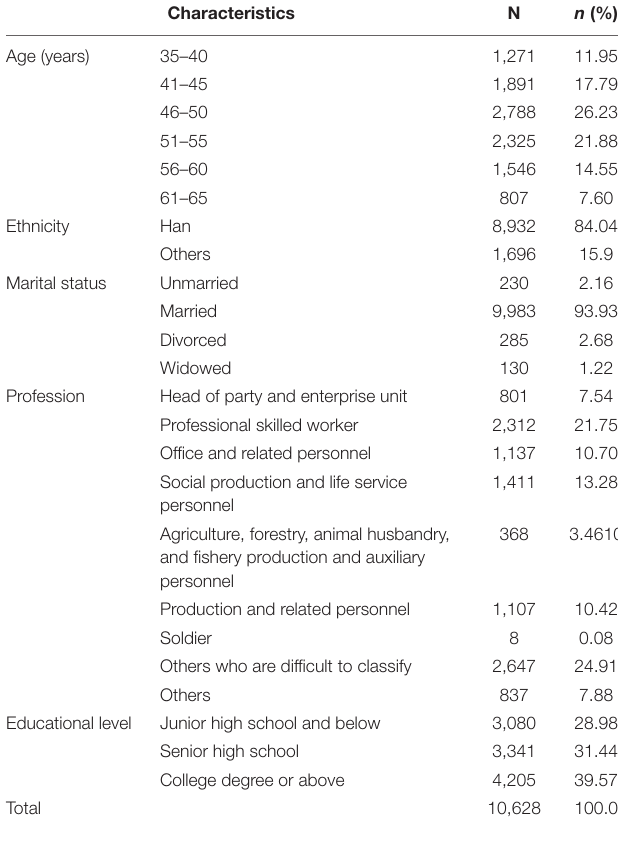
TABLE 1 | Basic information of cervical cancer screening